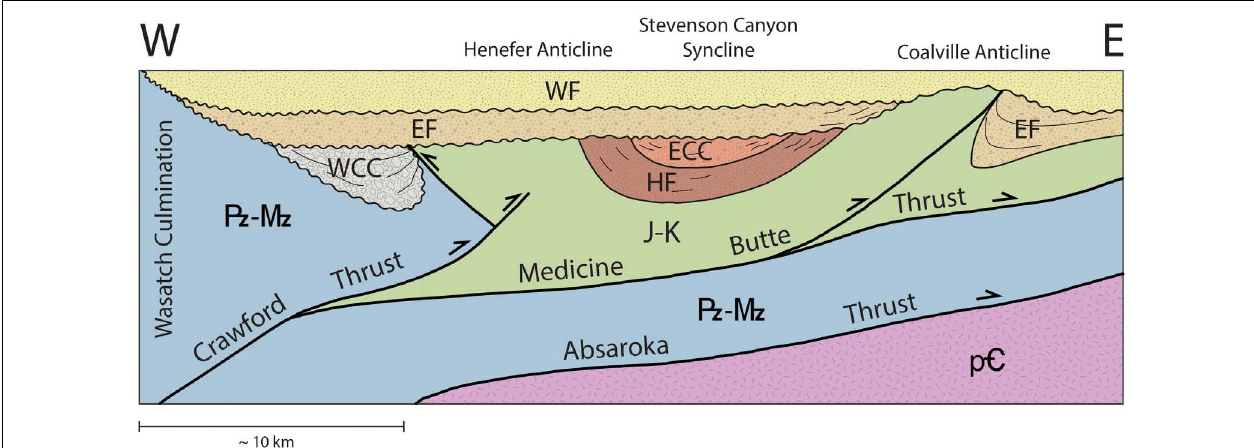
FIGURE 6 | Schematic cross-section showing key structural elements and stratigraphic relationships of the synorogenic sediments near the Echo Canyon study area. There is no vertical exaggeration; however, relative formation thicknesses are only roughly to scale. The Echo Canyon Conglomerate (ECC) is confined to the Stevenson Canyon Syncline where conformably overlies the fluvial Henefer Formation (HF). The ECC is truncated above by an angular unconformity with conglomerates of the Evanston Formation (EF). Also represented here are conglomerates of the Wasatch Formation (WF) and the Weber Canyon Conglomerate (WCC), the Paleozoic to Mesozoic (|-}) rocks of the Crawford and Absaroka thrust sheets, the Jurassic to Cretaceous (J-K) rocks of the Medicine Butte Thrust sheet, and the underlying Precambrian crystalline basement rocks (=). Modified from DeCelles